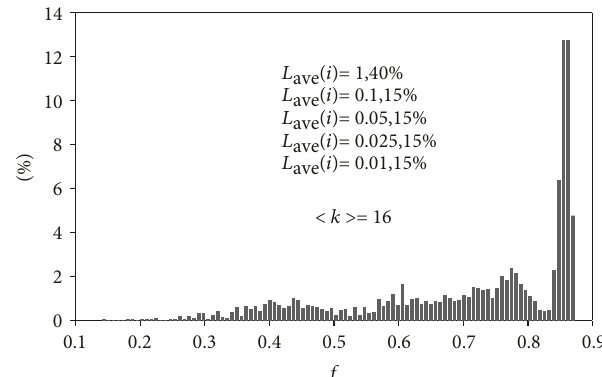
Figure 7: The infection distribution with di ff erent degrees of information association, when < k > = 16 .